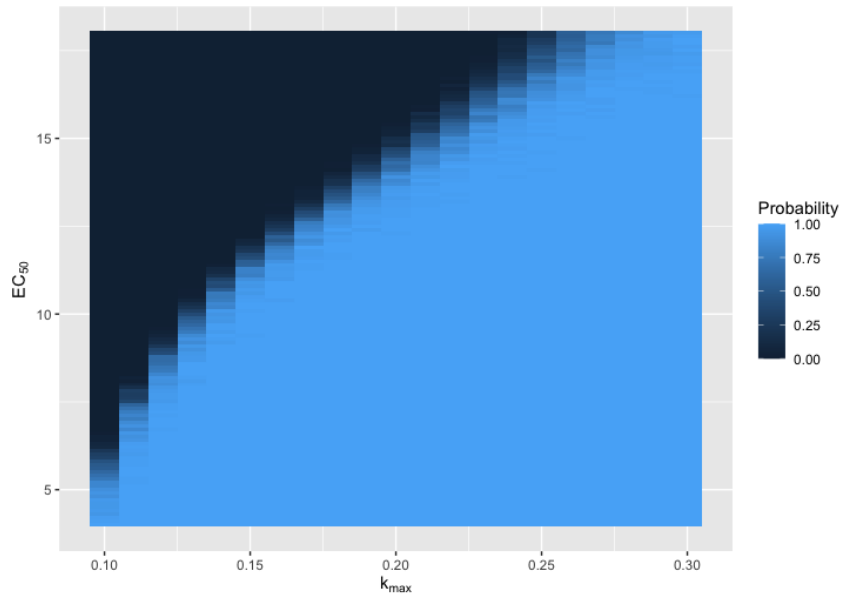
Figure 7. Sensitivity analysis showing the dependence of extinction probability on the k max and EC 50 . We take k max every 0.01 from 0.1 to 0.3 and EC 50 every 0.1 from 4 to 18. The other parameter values used are P init = 350, µ = 7.5, σ = 5, r p = 80, γ = 12, f = 0.004, δ p =